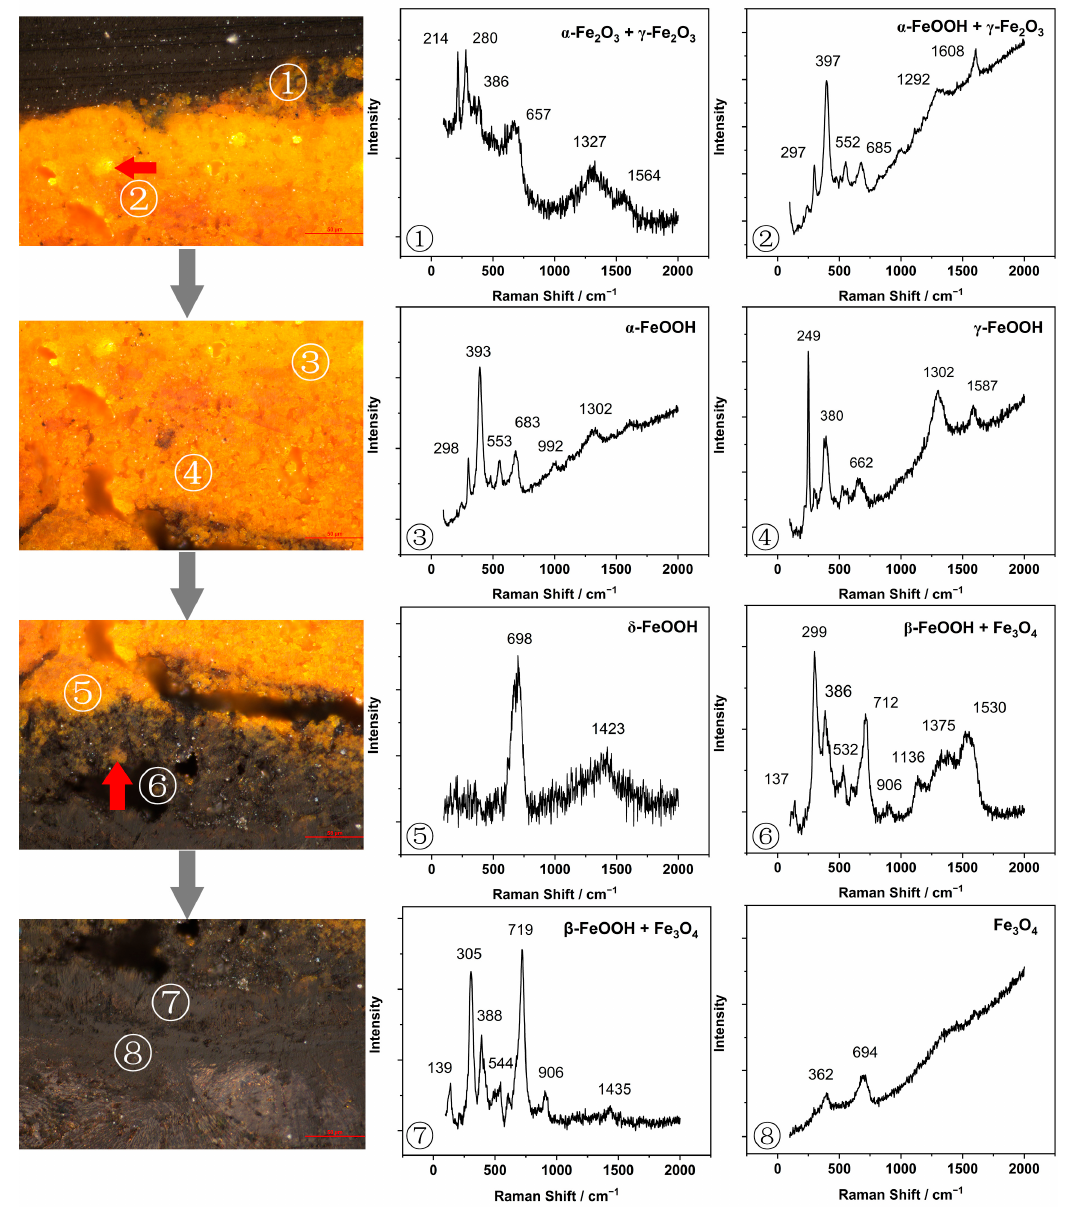
Figure 6. Raman spectra of rust layer A (red square in Figure 5). 1 (cid:13) – 8 (cid:13) were the main points for Raman